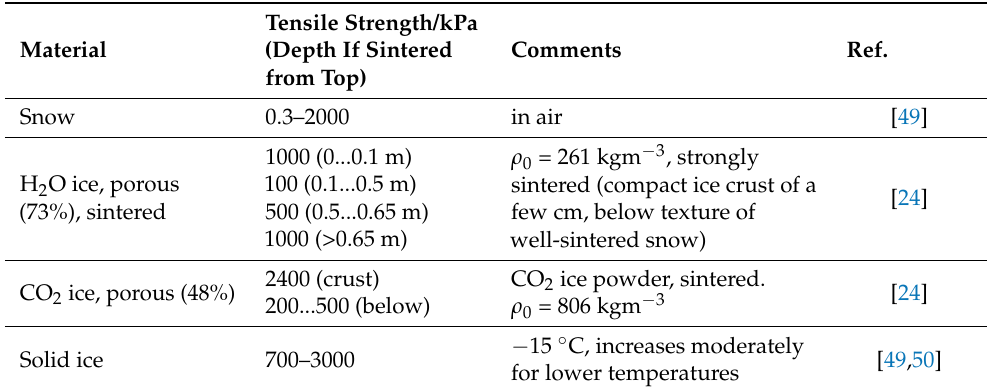
Table 1. Strength of snow and firn ice as a function of density; adapted from [48,49]. Note that the experimental data scatter significantly around the average values shown